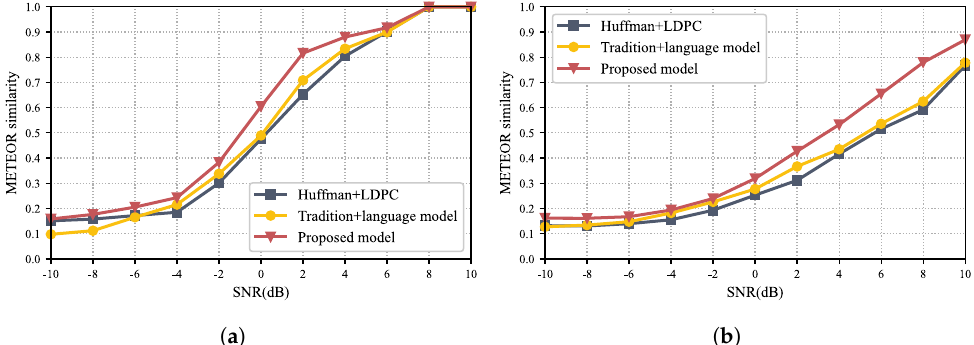
Figure 4. ( a ) METEOR score versus SNR over the AWGN channel. ( b ) METEOR score versus SNR over the Rayleigh fading